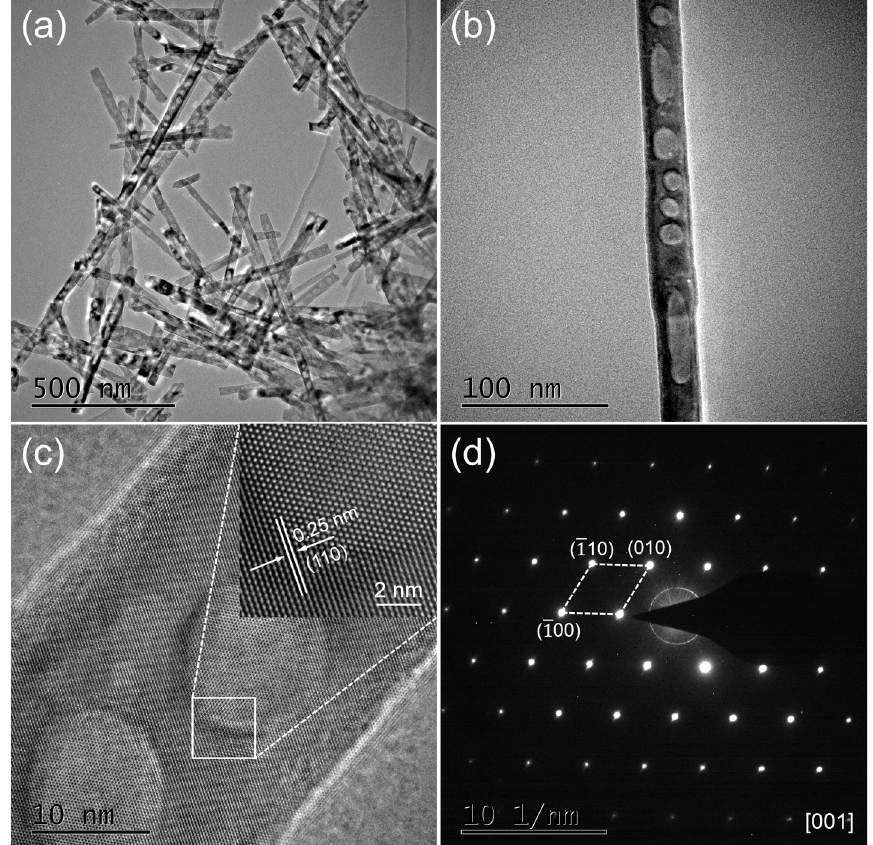
Figure 5. ( a ) High-magnification and ( b ) low-magnification TEM images of 1% Zn-doped α -Fe 2 O 3 nanowires. ( c ) HRTEM image of 1% Zn-doped α -Fe 2 O 3 nanowires. ( d ) SAED pattern of 1% Zn-doped α -Fe 2 O 3 nanowires.